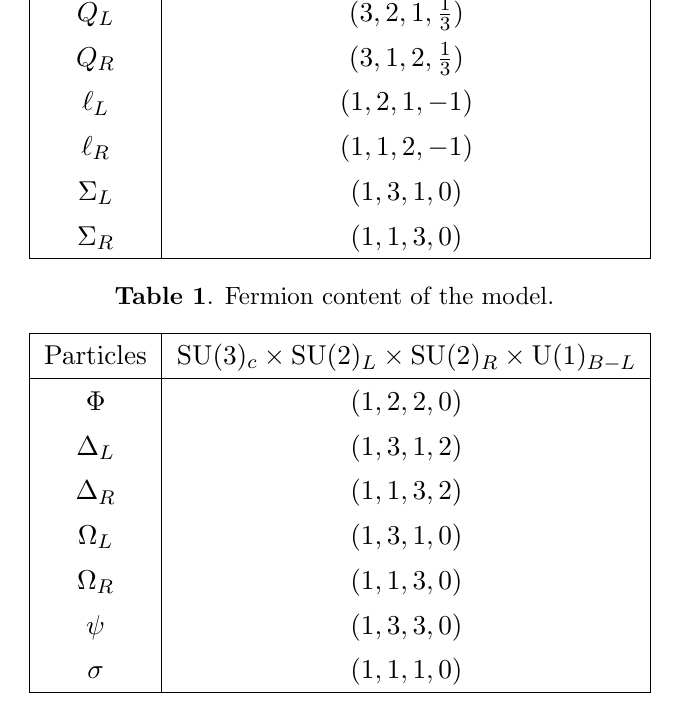
Table 2 . Scalar content of the